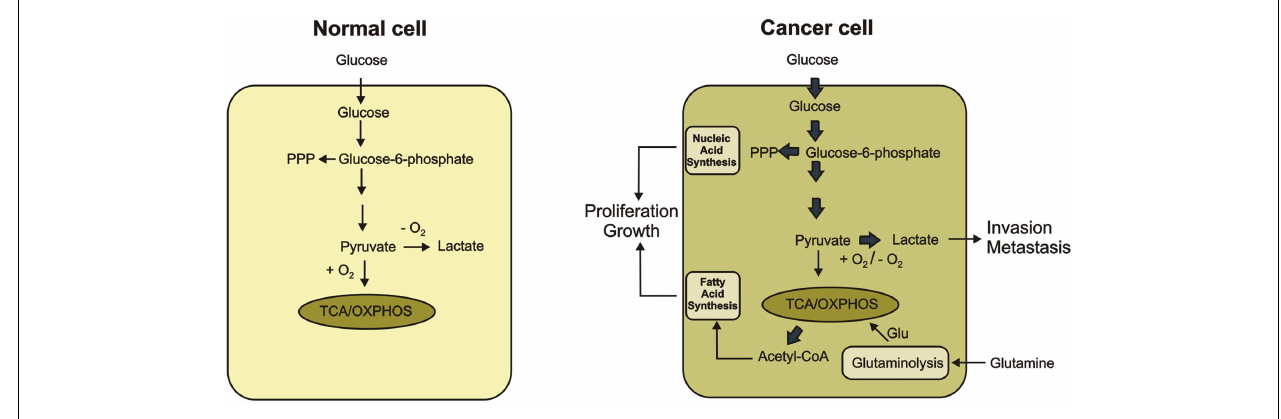
glycolytic pathway generates metabolic intermediates such as glucose-6-phosphate, which is used for the synthesis of nucleic acids through the pentose phosphate pathway. Glutamate produced during glutaminolysis serves as the major substrate to refuel theTCA cycle. Citrate-derived acetyl CoA is used for lipid production.The increased synthesis of nucleic acid and lipids promote proliferation and growth of cancer